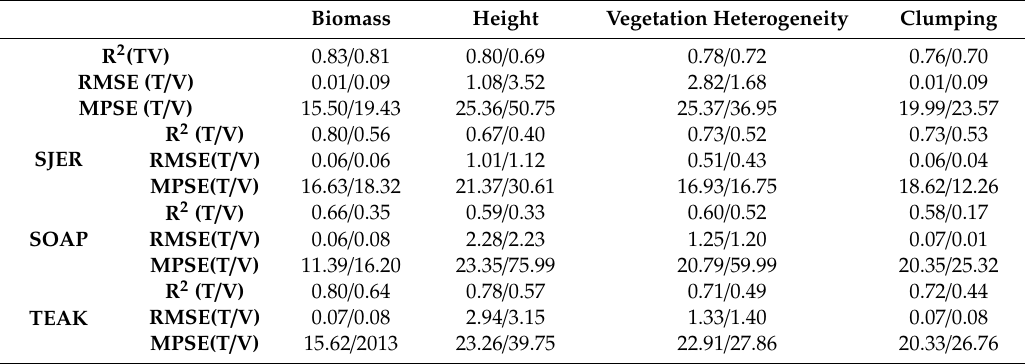
Table 3. The fit of random forests to the regression model, measured by the coe ffi cient of determination (R 2 ), therootmeansquareerror(RMSE)andthemeanpercentstandarderror(MPSE)(seeSupplementary Materials, Table S3) for the four structural variables and for the training (i.e., T) and validation (i.e., V) datasets by individual site. Biomass Height Vegetation Heterogeneity